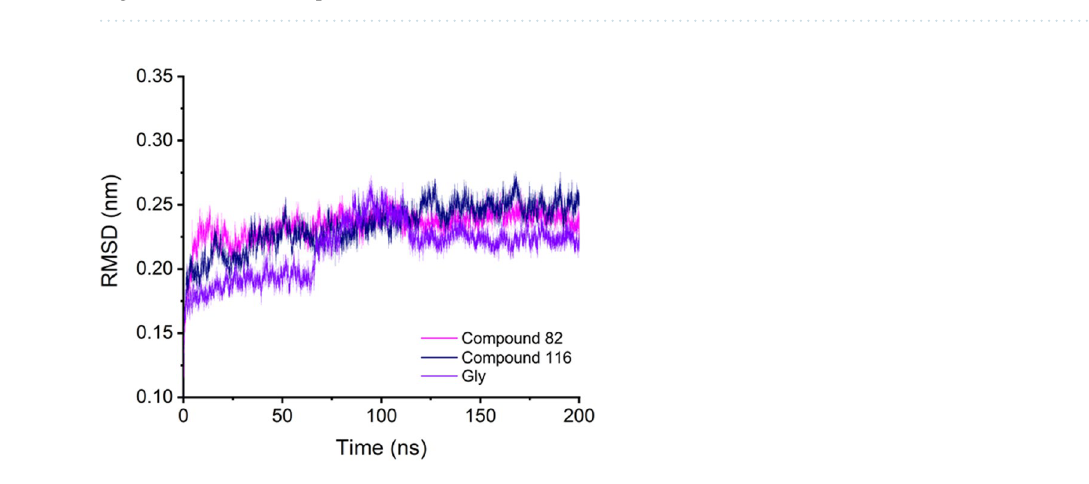
Figure 7. 2D and 3D representation of the Interaction of Gl with FMN and GO.